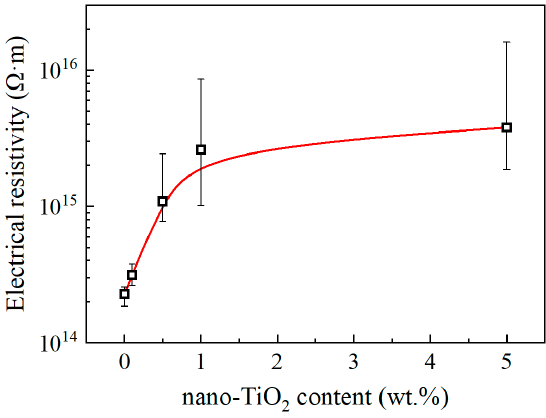
Figure 8. Electrical resistivity and nano-TiO 2 content.